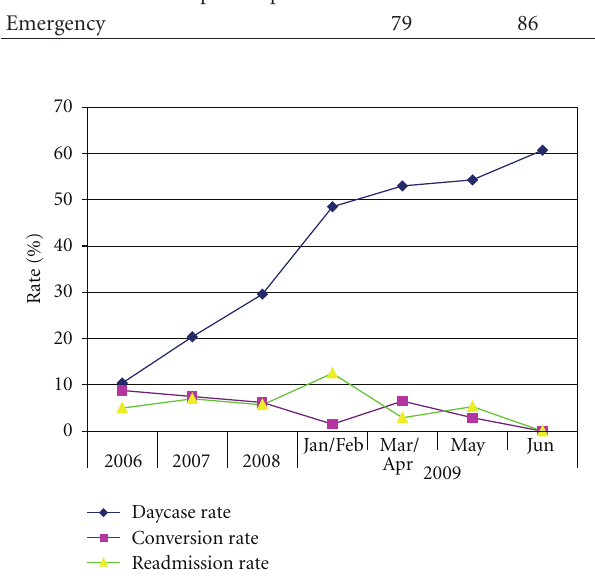
Figure 3: Daycase, conversion and readmission rates following laparoscopic cholecystectomy between January 2006 and June 2009.